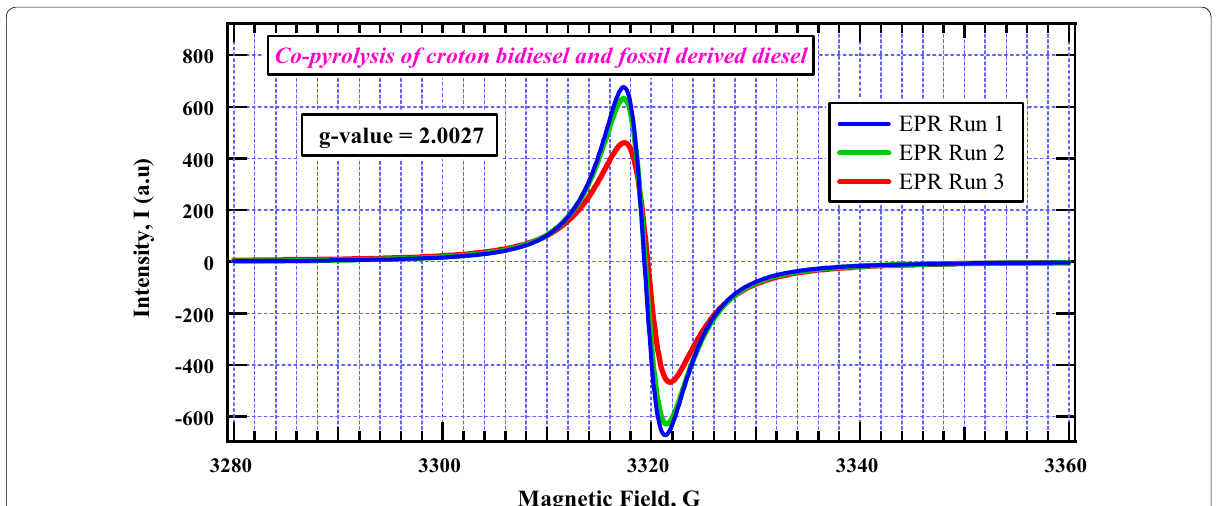
Table 1 The EPR parameters for the thermal char formed from the co‑pyrolysis of the binary mixture of biodiesel and conventional diesel